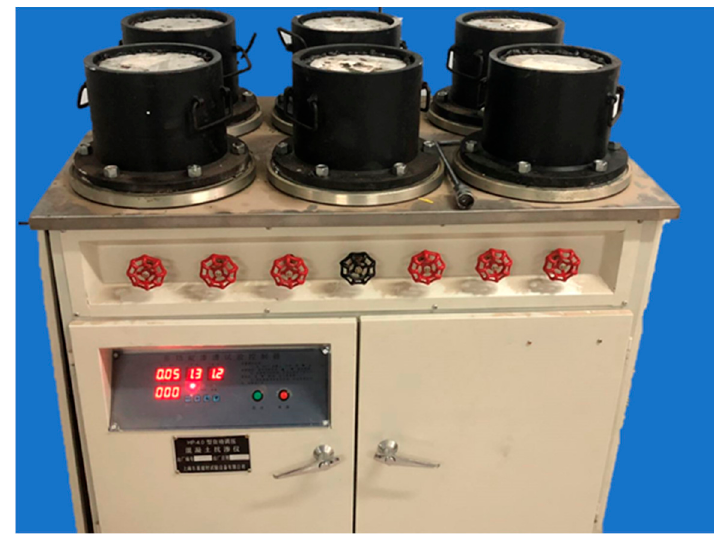
Figure 6. Instrument of permeability resistance of concrete.